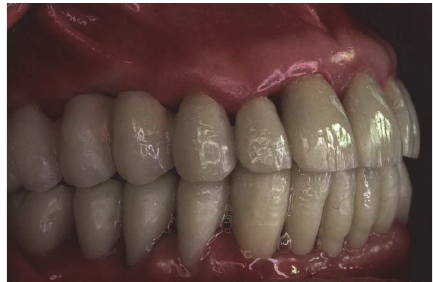
Figure 8: First set of temporary restorations relined and occlusally